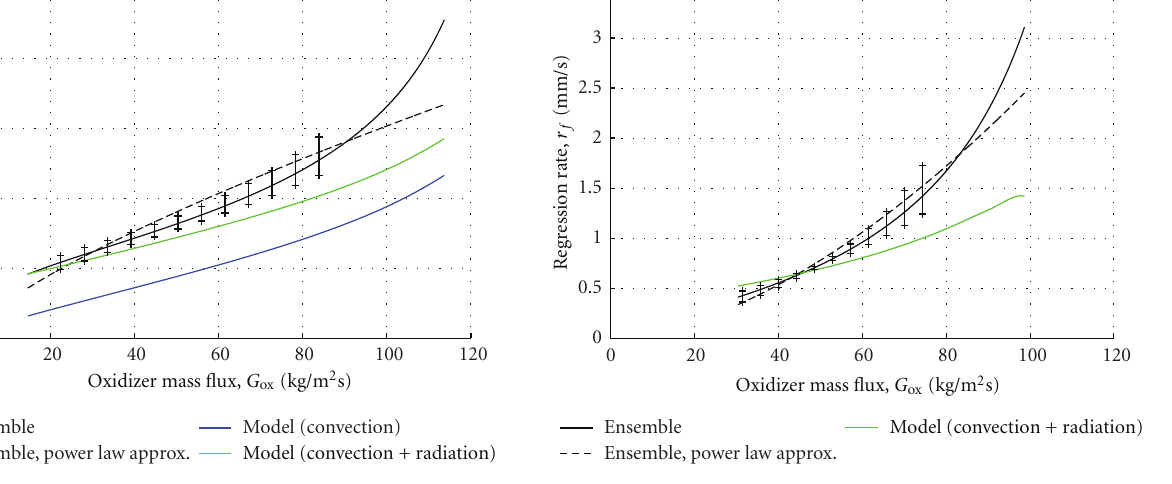
Figure 13: HTPB baseline: ensemble average of experimental data for r f ( G ox ) with its power law approximation and extended Greatrix model.